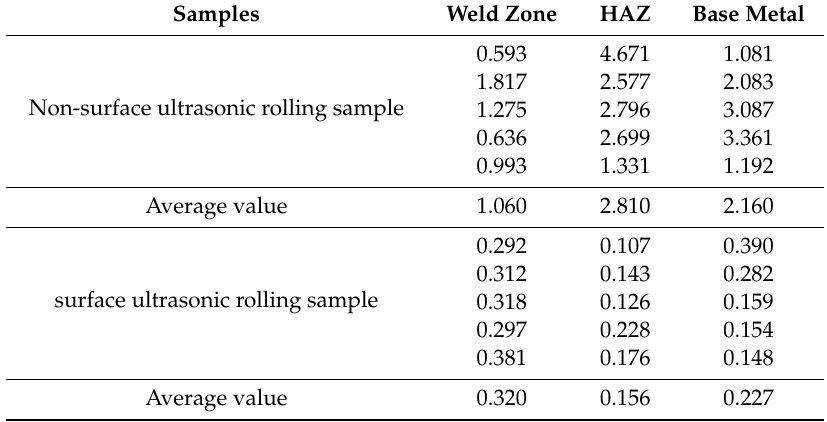
Table 3. The variation of surface roughness of T4003 ferritic stainless steel welded joint before and after SURT (unit: µ m).